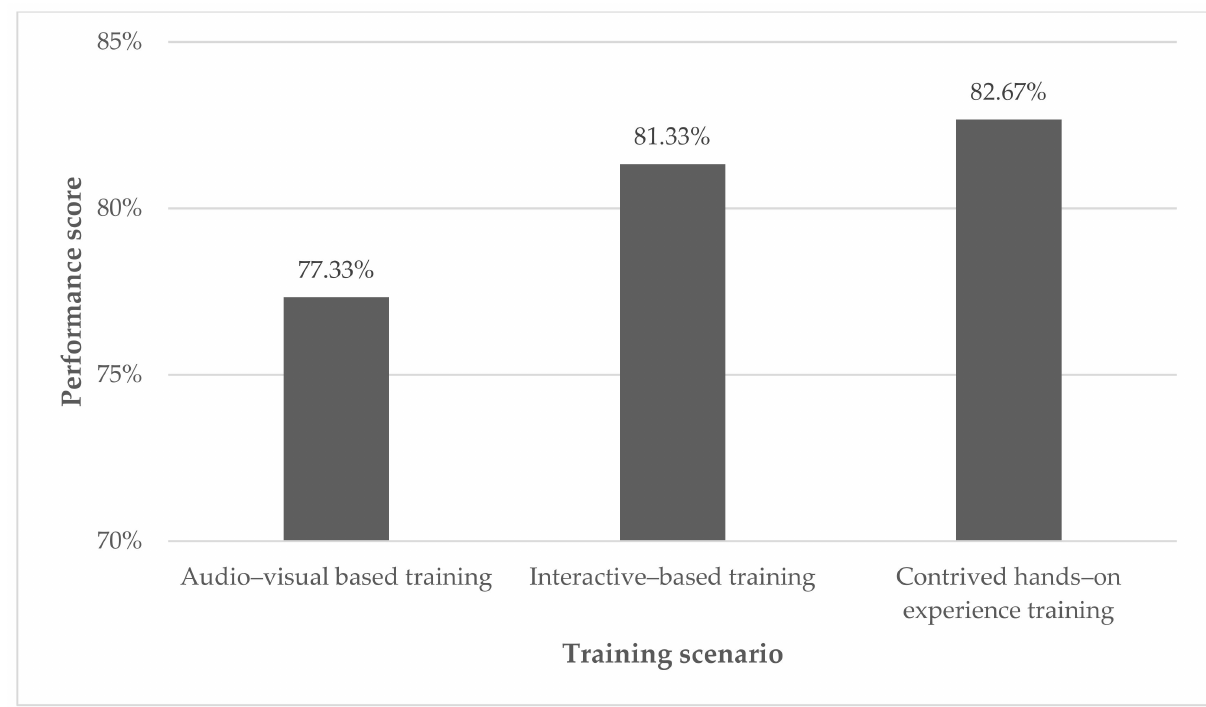
Figure 6. Mean performance score based on different learning methods in the VR environment.